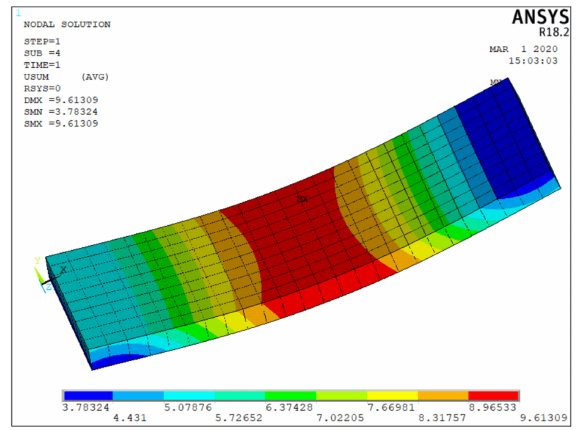
Figure 14. Displacement nephogram of composite floor in vertical